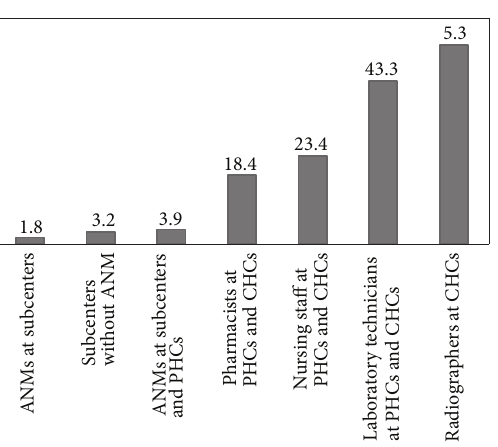
Figure 2: Shortfall in various categories of paramedical staff in rural healthcareset-up,allIndia.Source:basedonfiguresinRHSBulletin, 2012